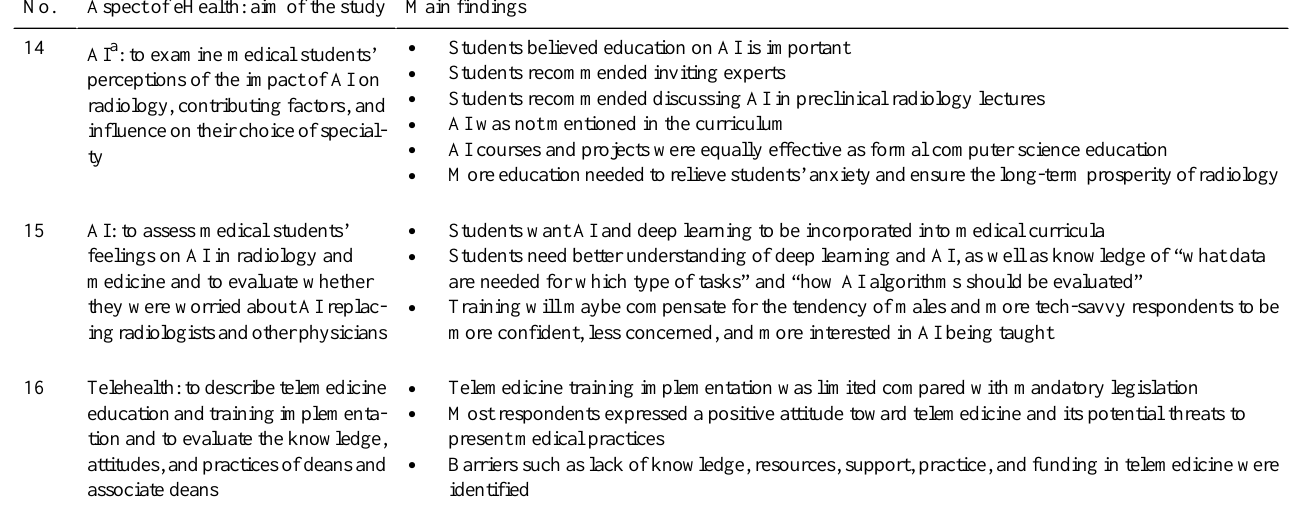
Table 3. Summary of the main findings regarding medical students’training in eHealth for articles that did not contain interventions. Main findingsAspect of eHealth: aim of the